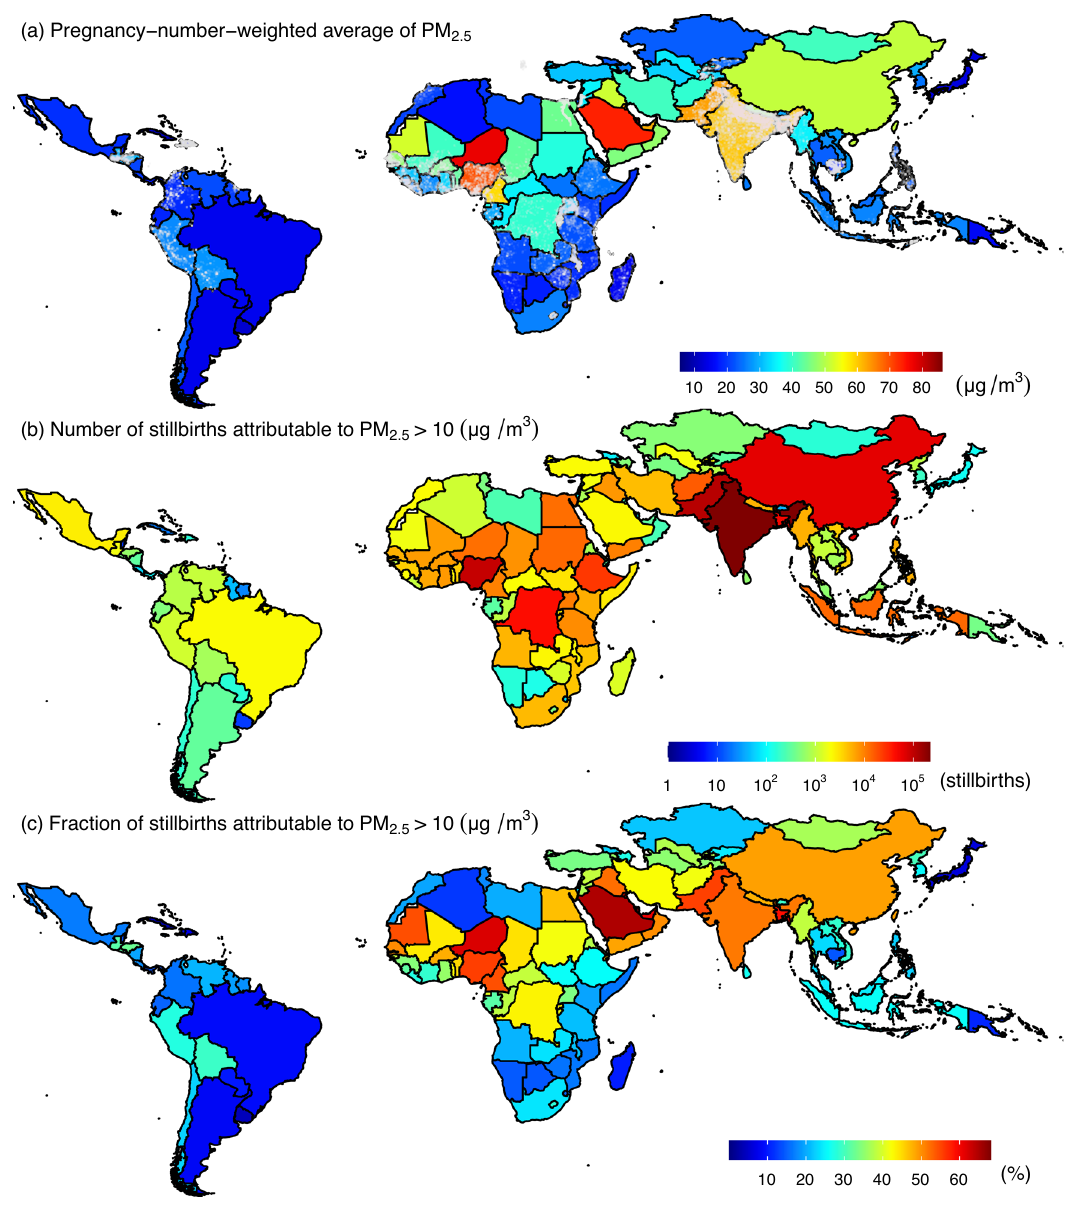
Fig. 1 | Maps of stillbirths attributable to PM 2.5 exposure in the 137 countries. PM 2.5 exposure ( a ), number ( b ), and fraction ( c ) of stillbirths attributable to exposure in 2015 in the 137 countries. Gray dots in panel ( a ) are the surveyed